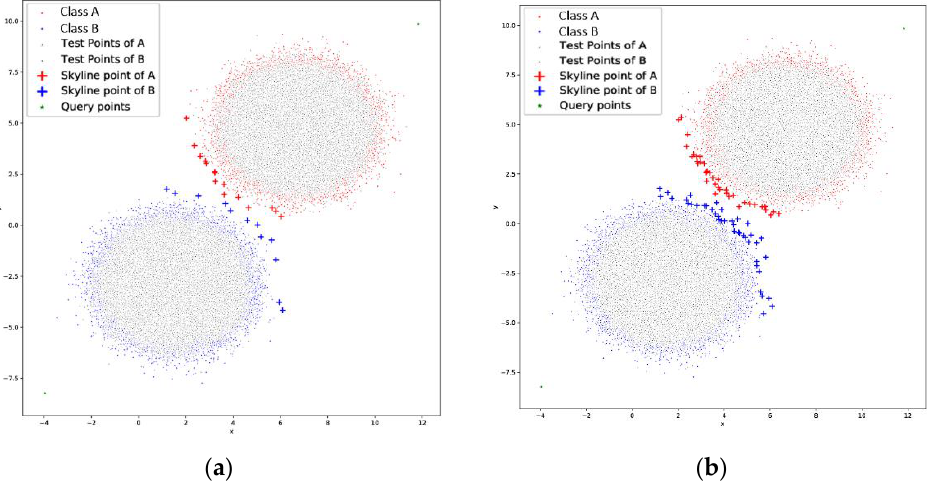
Figure 3. ( a ) Single skyline; ( b ) double skyline.